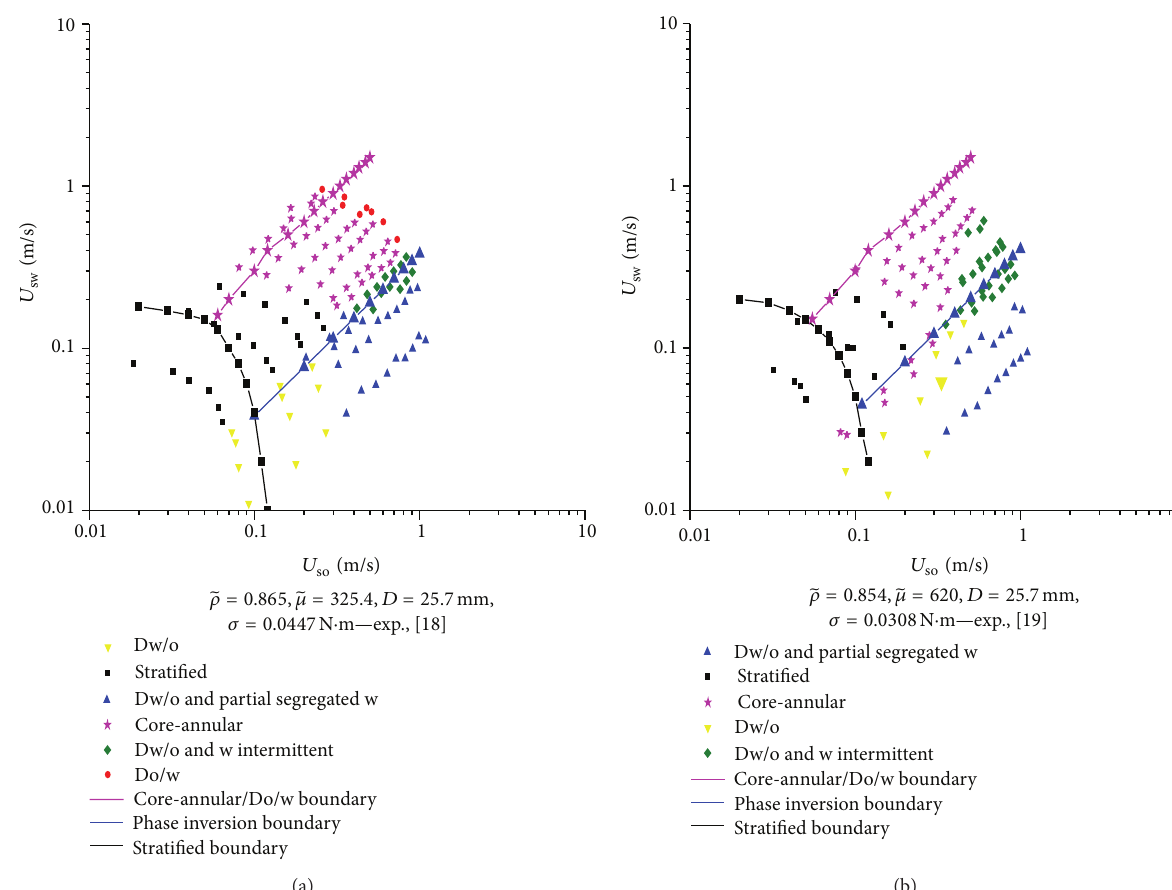
Figure 4: Comparison between prediction (lines) and experimental data (symbols) of oil-water